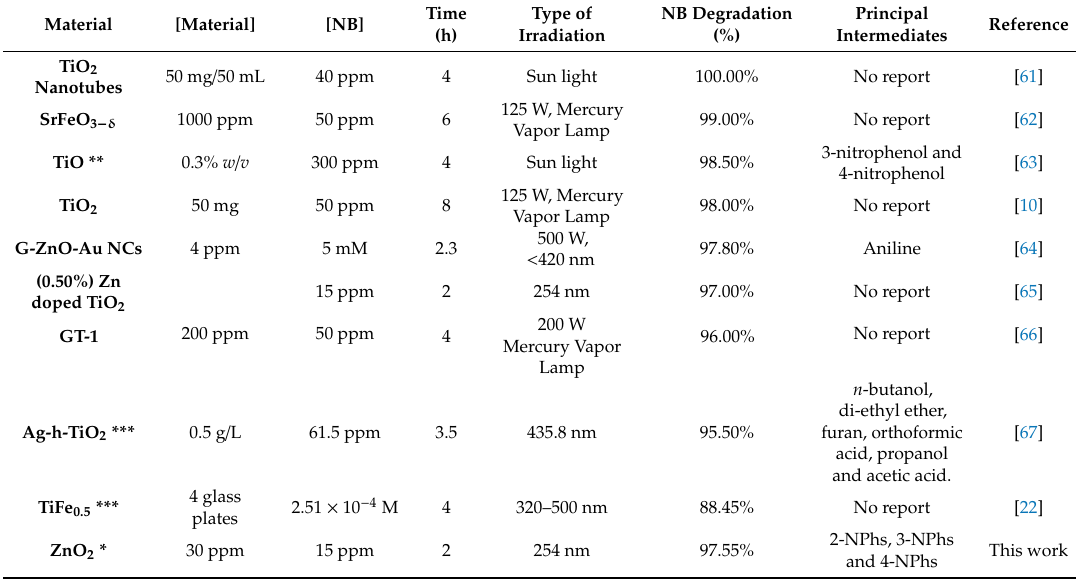
Table 2. Comparison of photocatalytic activity of ZnO 2 with the reported various catalysts for NB